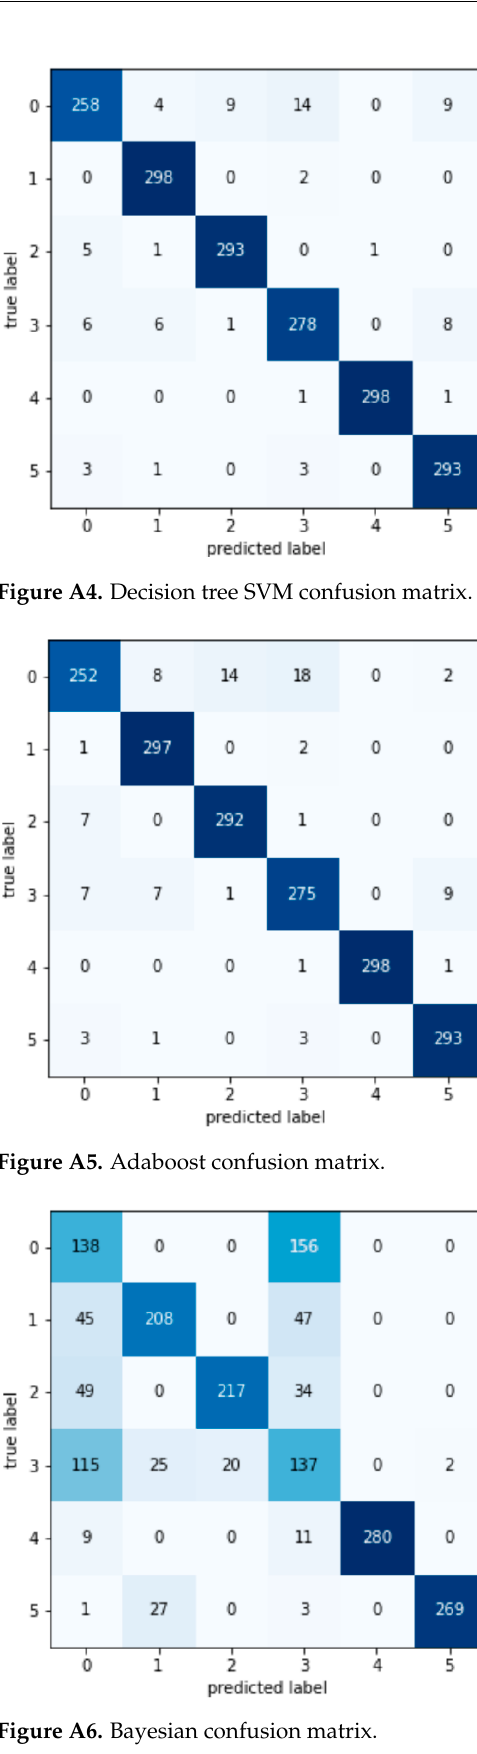
Figure A3. RBFSVM confusion matrix.